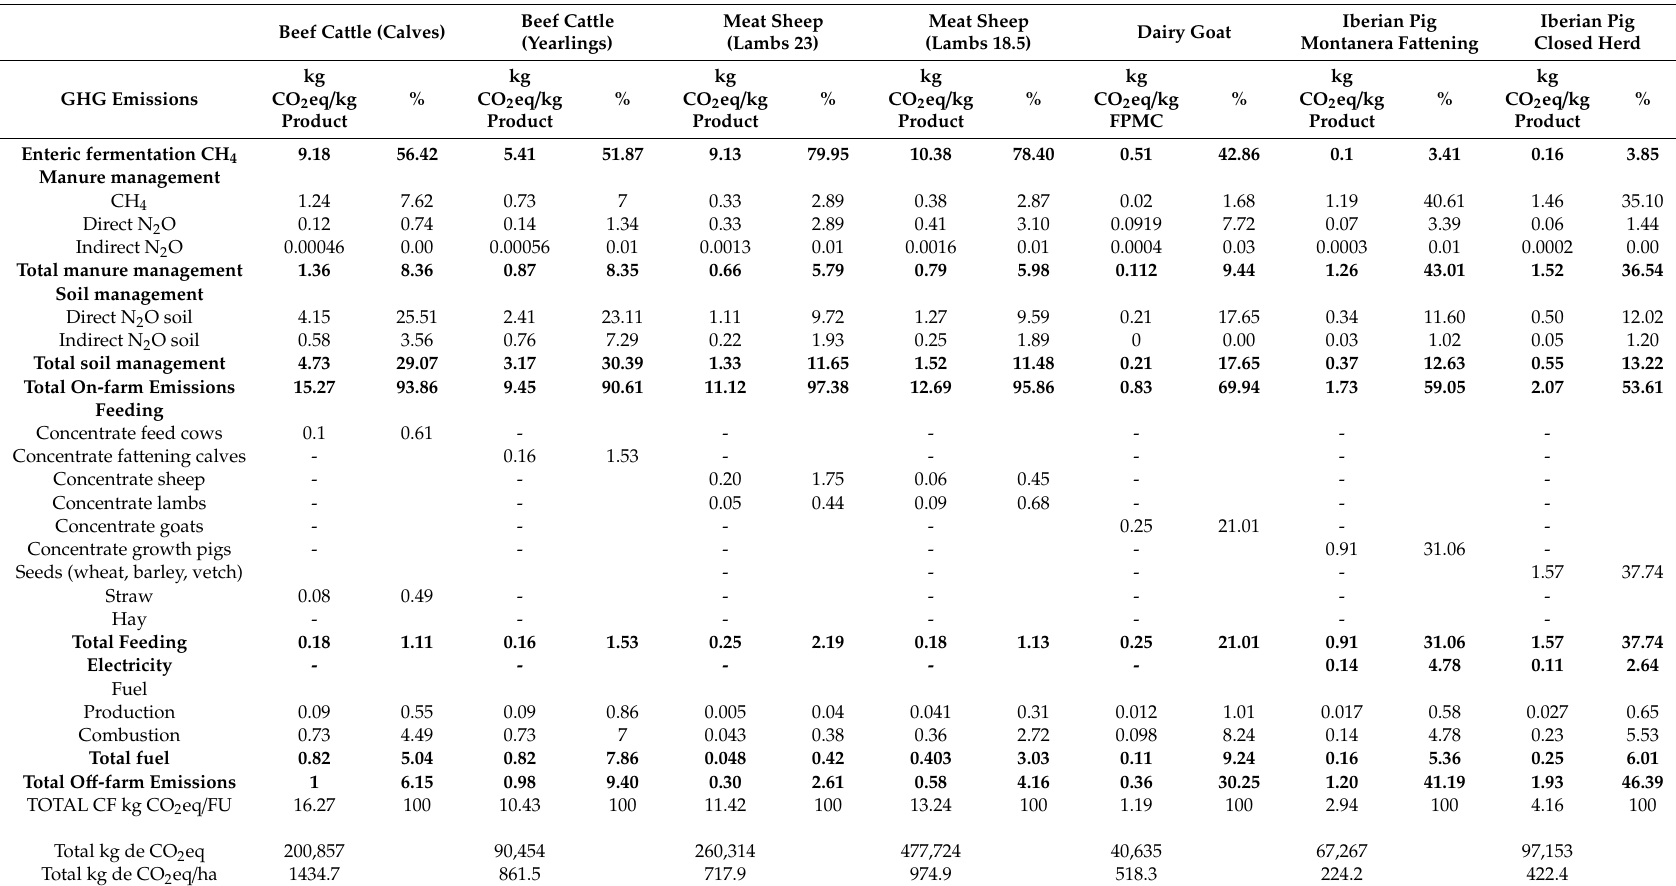
Table 4. Carbon footprint per functional